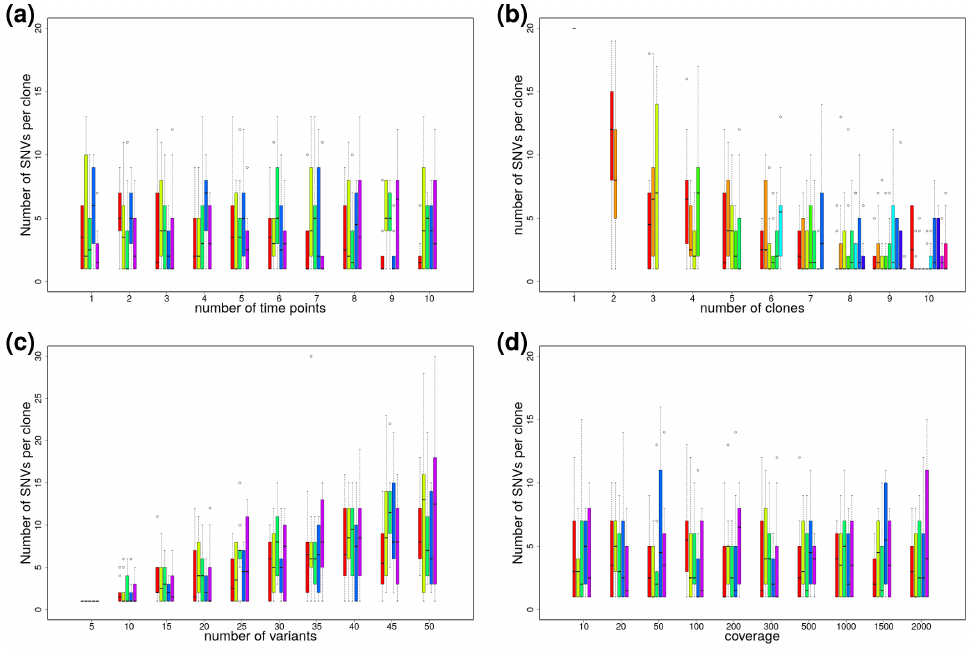
Figure A5. Boxplots showing the number of SNVs per cluster considering different numbers of